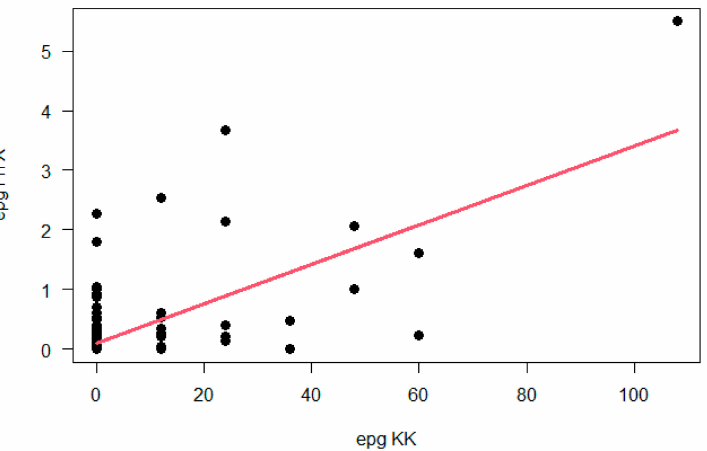
Figure 3. Case-to-case comparisons of the egg burden values estimated by the Kato-Katz and Helmintex methods. The correlation coefficient is